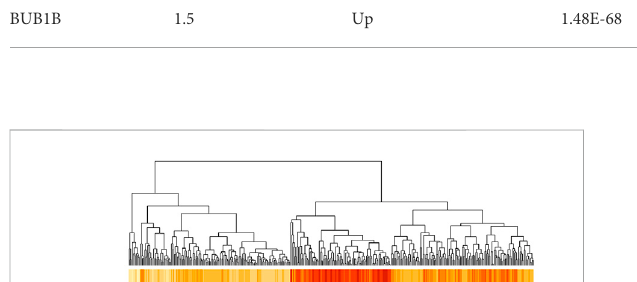
To investigate the association of KGs (AURKB, BIRC5, TOP2A, ACTB, ASPM, EGFR, and BUB1B) with different subtypes and progression stages of BC by the independent datasets, we performed box plot analysis based on independent RNA-Seq pro fi les from the UALCAN online database. Figure 5 displayed the box plots for the expressions of KGs with each BC subtypes (normal, luminal, HER2-positive, and TNBC), where blue indicates the normal group and orange, green, and brown indicate luminal, HER2-positive, and triple- negative BC, respectively. We observed the signi fi cant differential expression patterns between the normal group and the subtypes of the BC group. Supplementary Figure S2 shows that the expression patterns of KGs with different BC progression stages signi fi cantly differentiated from the control group. Therefore, proposed KGs (AURKB, BIRC5, TOP2A, ACTB, ASPM, EGFR, and BUB1B) may play a signi fi cant role for the diagnosis of TNBC at the earlier stage.